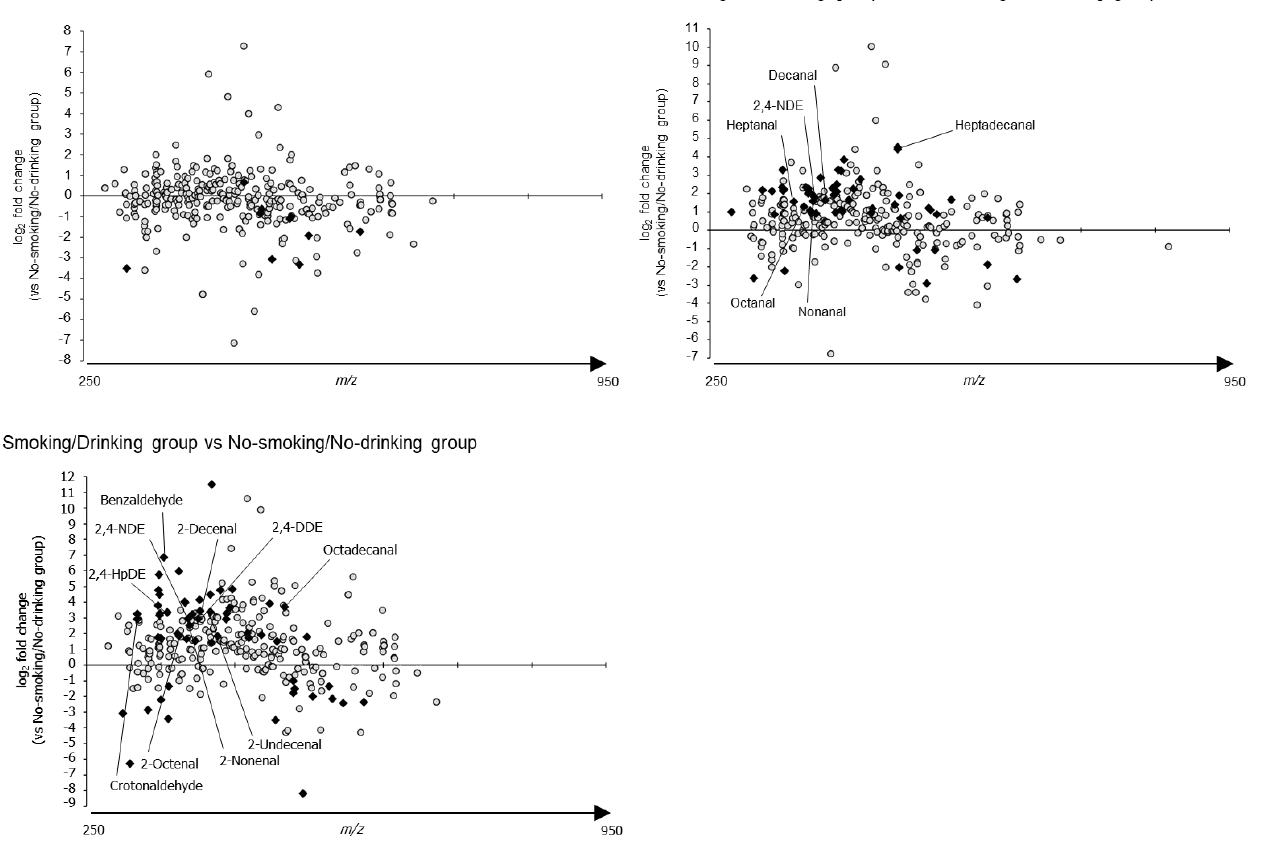
Figure 3. The profiles of reactive carbonyl species (RCS) detected in the plasma samples of each group as compared to the no-smoking and no-drinking group. ( a ) No-smoking and drinking group; ( b ) Smoking and no-drinking group; ( c ) Smoking and drinking group. The gray circles indicate the levels of each RCS, and closed diamonds indicate the levels of RCS that showed significant differences as compared to those of the no-smoking and no-drinking group ( p < 0.05) in 1-way analyses variance with post hoc Bonferroni analysis.